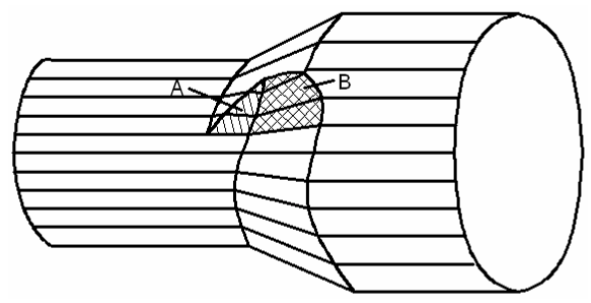
Figure 8. Contact area during CWR process.